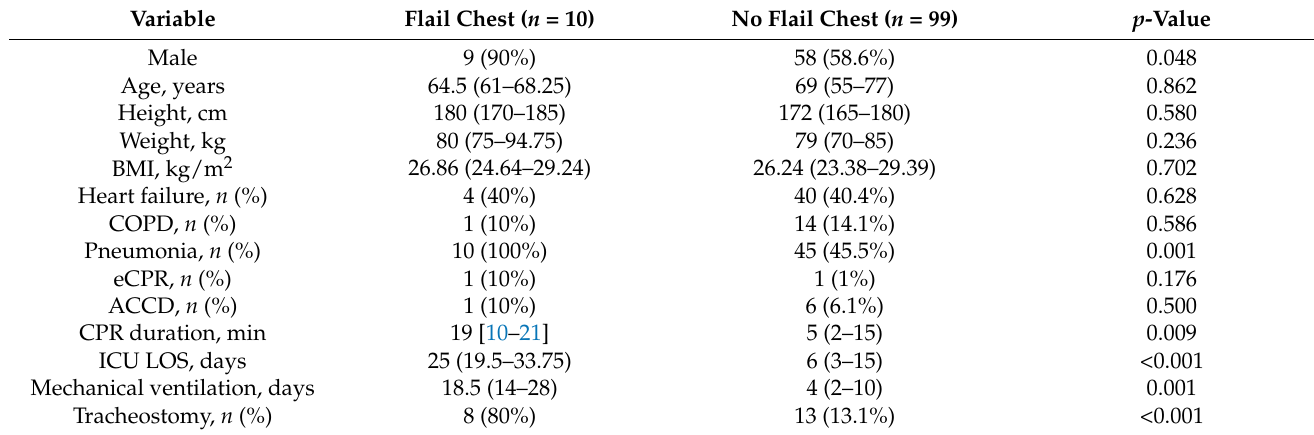
Table 3. Characteristics of patients with and without CPR-related flail chest.